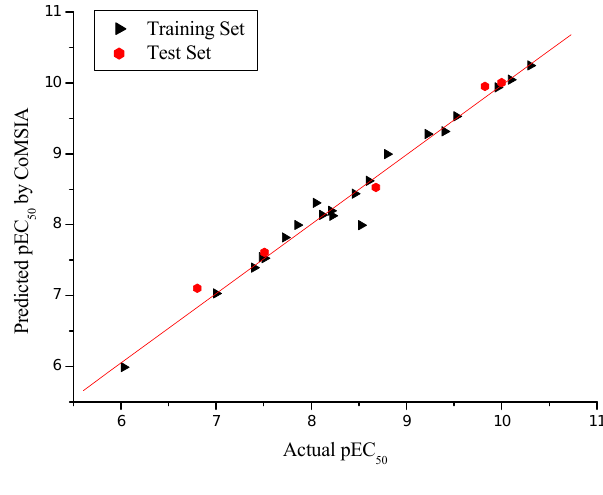
Figure 2. Graph of actual versus predicted pEC CoMSIA.